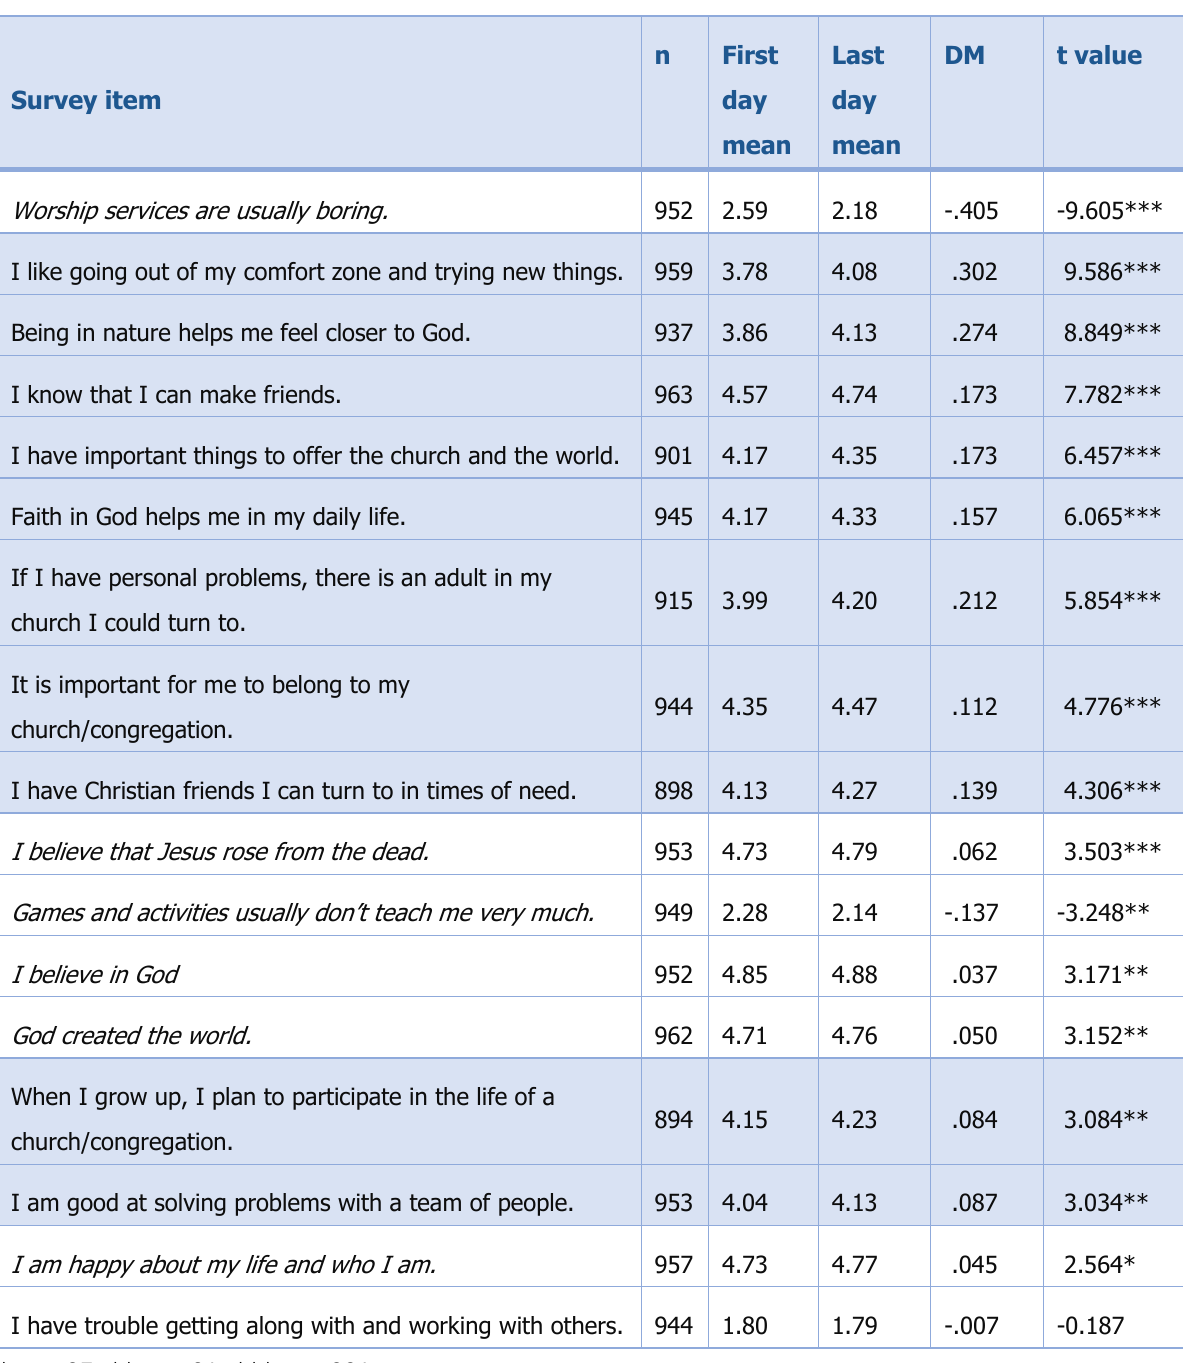
n First Last day day mean